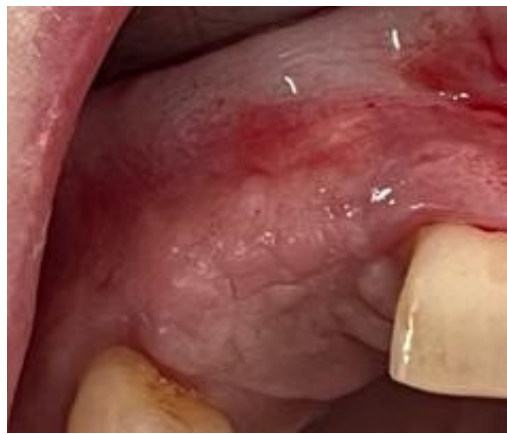
Figure 9. Aspect of the soft tissues (suitable for the mesh to be removed), after six months.